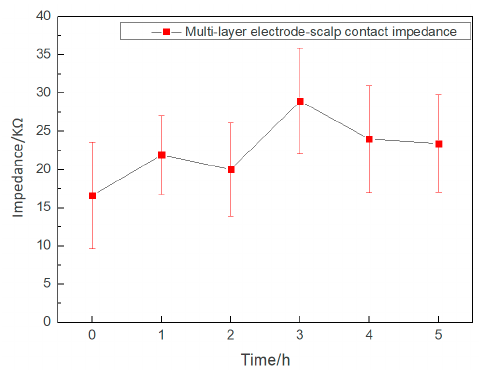
Figure 8. Changes of the semi-dry electrode–scalp contact impedance during the 5-h experiment.